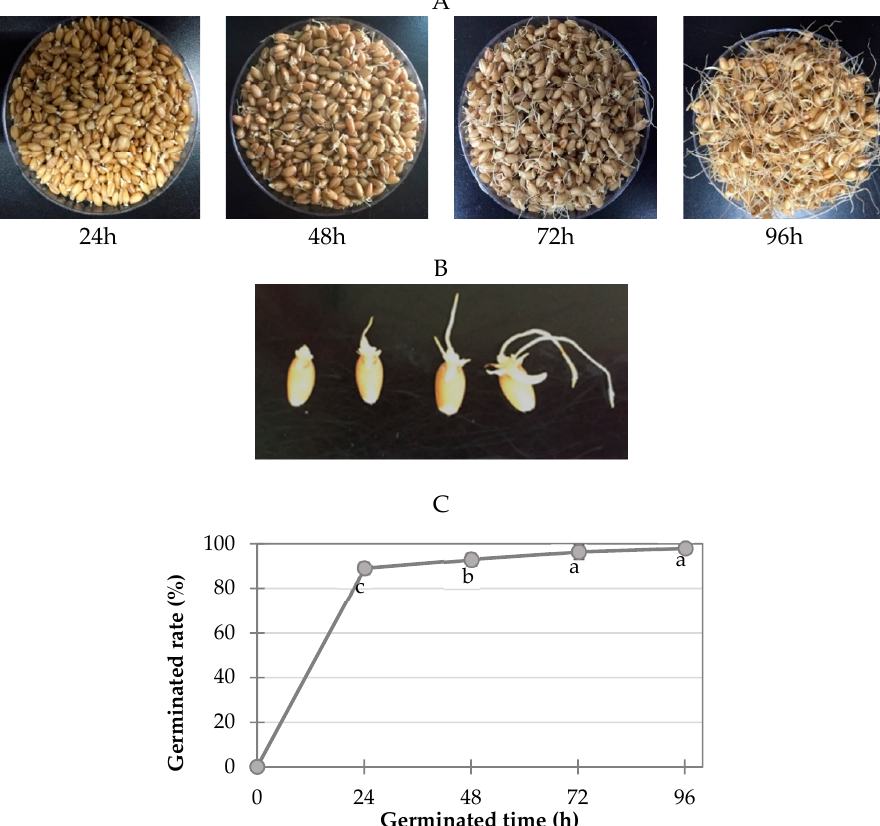
Figure 4. Wheat samples germinated for various times (24 h, 48 h, 72 h, and 96 h; ( A , B )) and the germination rate ( C ) at each germination time point.